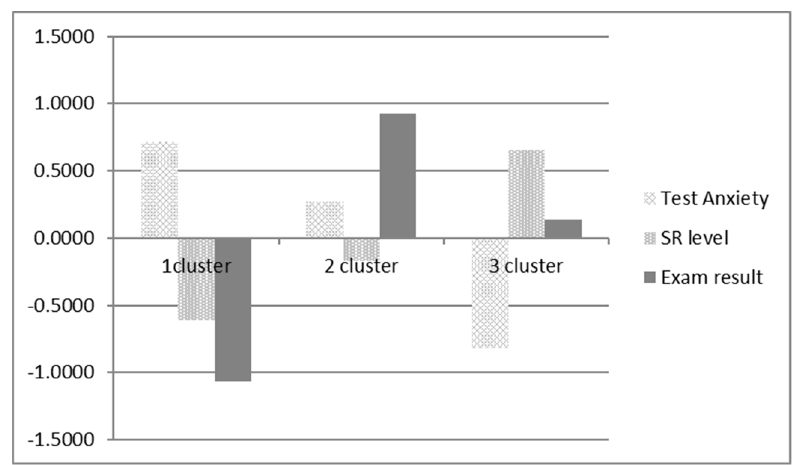
Figure 1. Clusters of students with different levels of anxiety, self-regulation, and USE result.